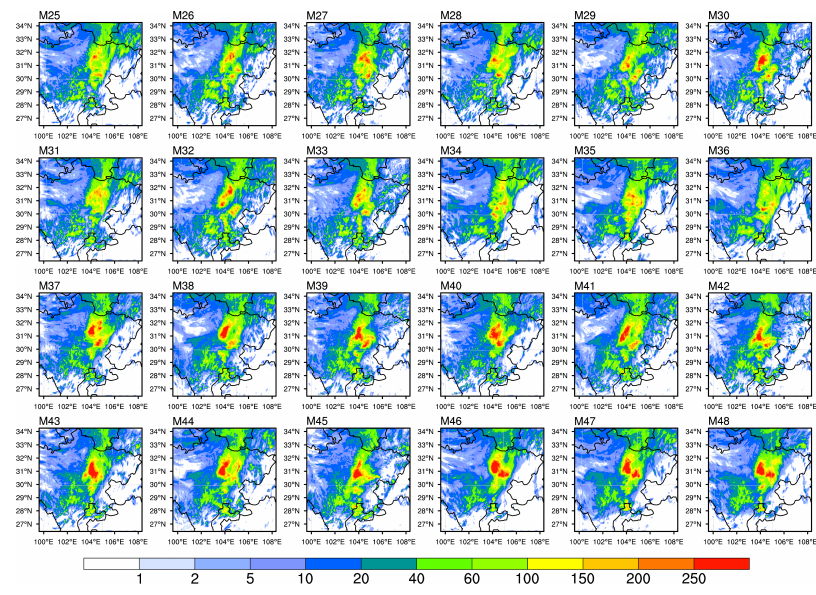
Figure A2. Same as Figure A1, but for the members from M25 to M48.